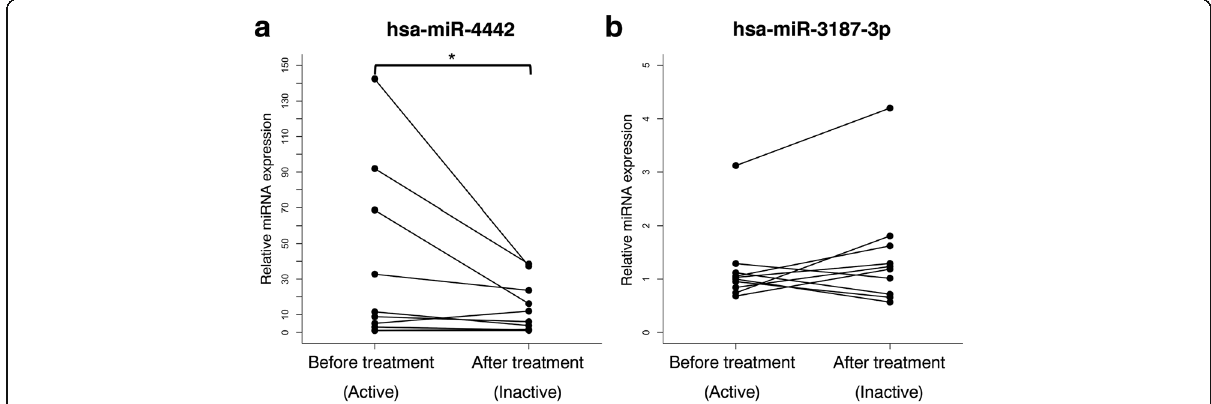
Fig. 3 Validation of hsa-miR-4442 and hsa-miR-3187-3p expression in plasma of PM/DM patients. Quantitative RT-PCR was performed to confirm the differential expression of has-miR-4442 and hsa-miR-3187-3p in plasma of before (active) and after treatment (inactive) patients ( n = 10). a The expression of hsa-miR-4442 was significantly decreased after treatment (* P <0.05). b There was no significant difference in the expression of